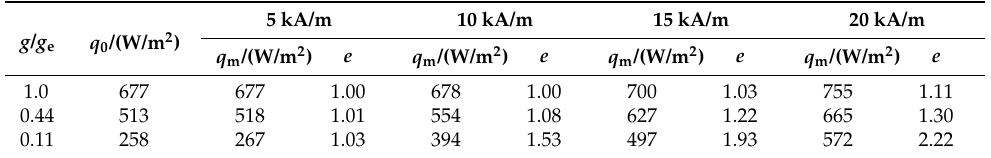
Table 2. Averaged heat flux and heat flux enhancement ratio under a uniform magnetic